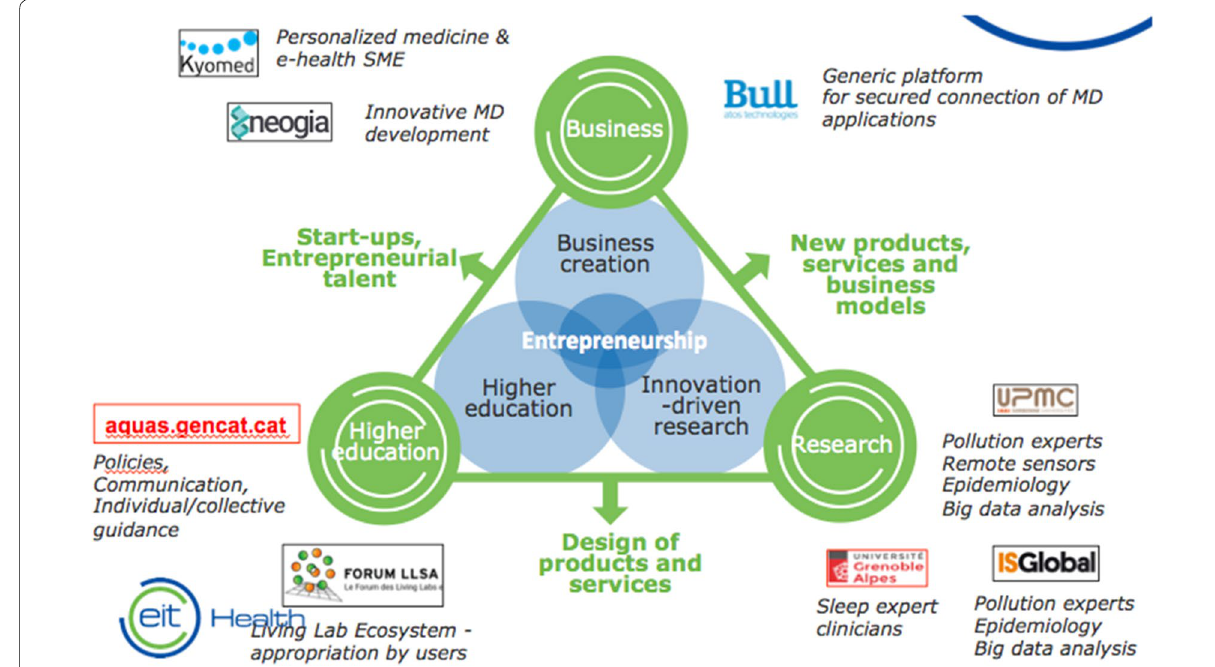
Fig. 5 The POLLAR knowledge